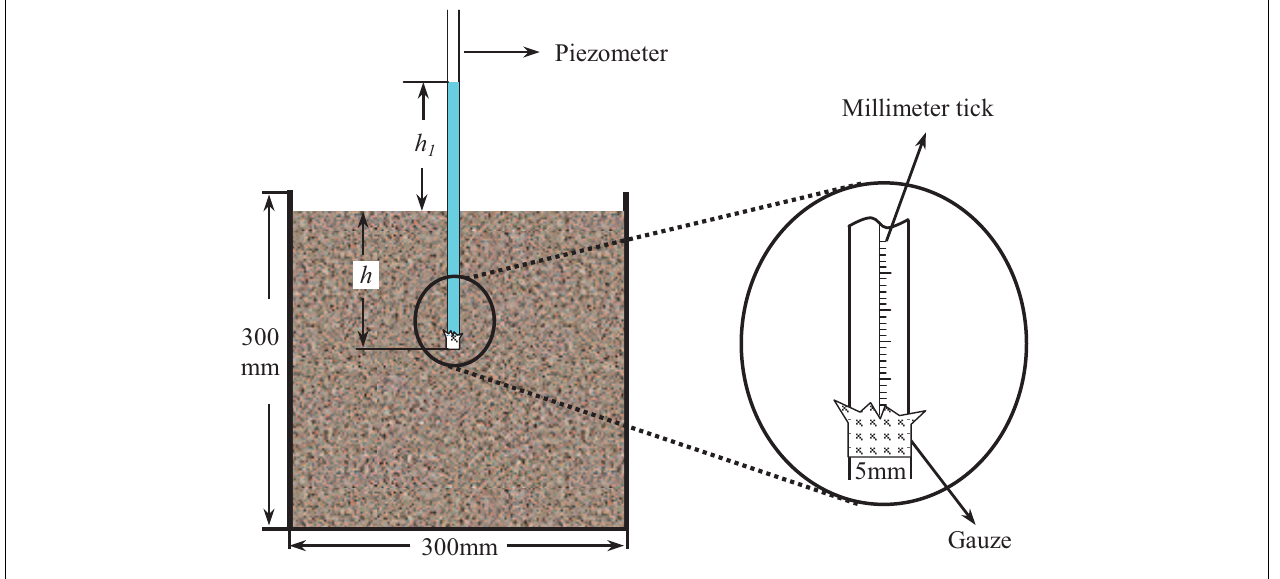
FIGURE 5 | Schematic diagram of experimental device.